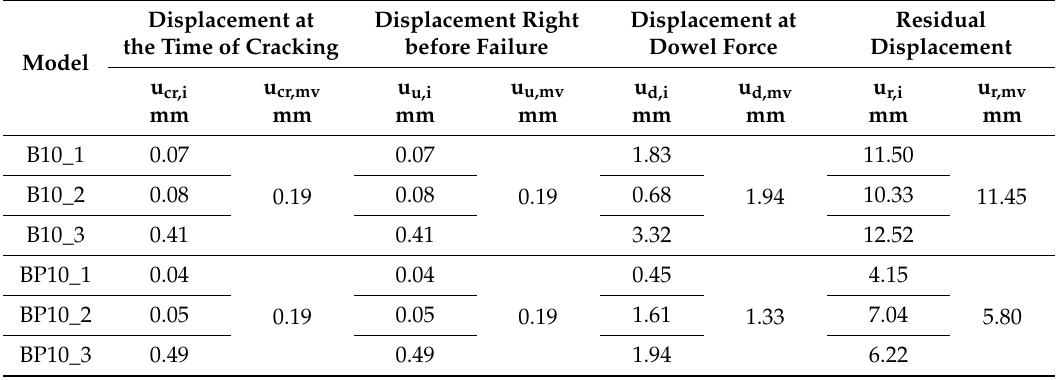
Table 10. Test results for reinforced joints (displacements).